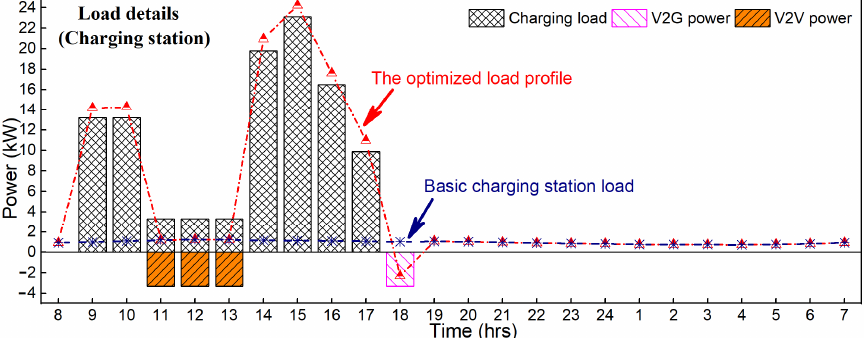
Figure 13. Outcome for EV charging of the charging station: basic charging station load refers to the charging station load without EV load profile; the optimized load profile refers to the basic charging station load plus the aggregated EV charging/discharging result based on the proposed model.